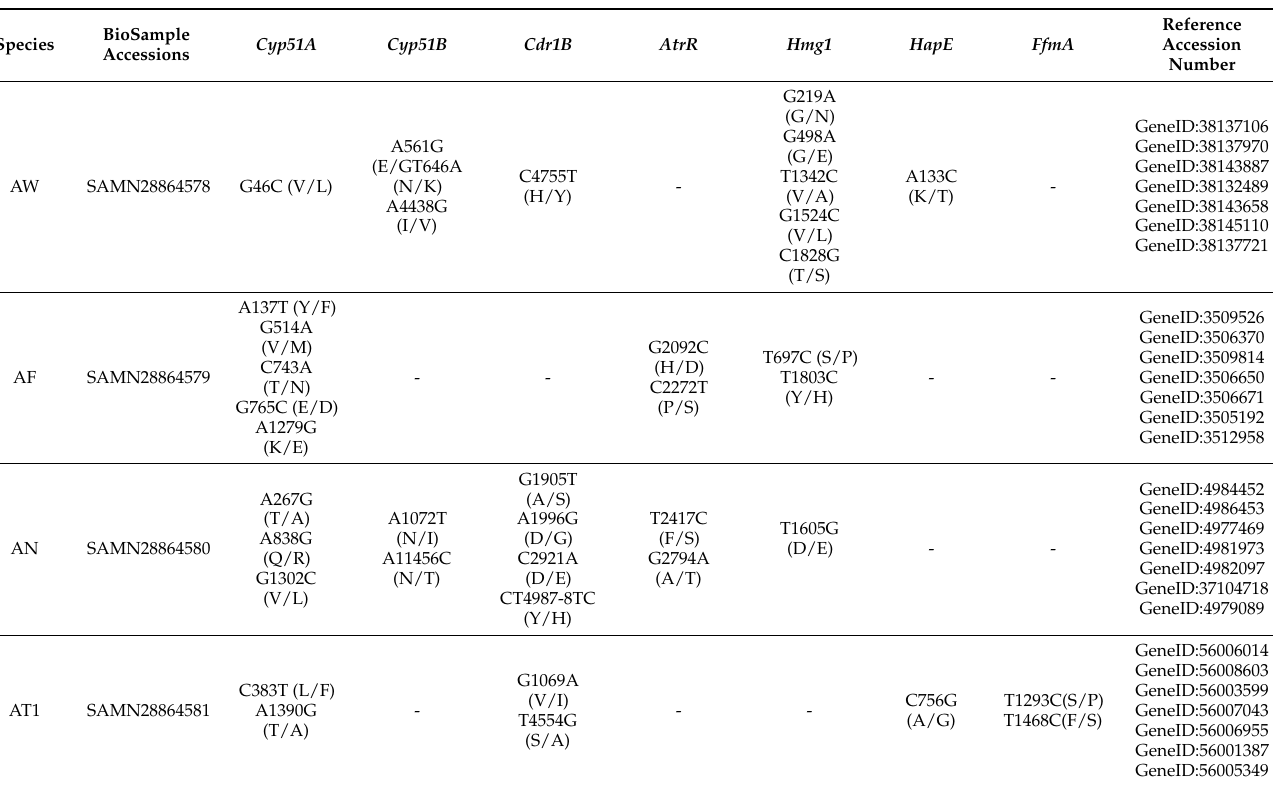
Table 2. The list of nonsynonymous substitutions along different gene loci in study Aspergillus